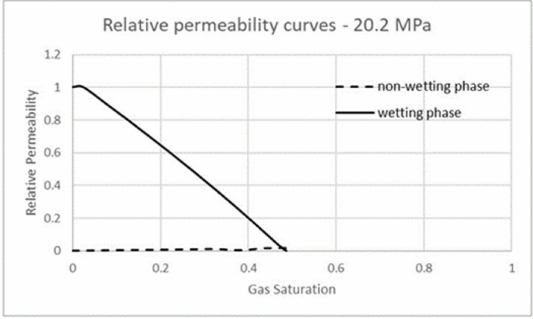
Figure 18. Relative permeability curves at inlet pressure of 20.2 MPa.